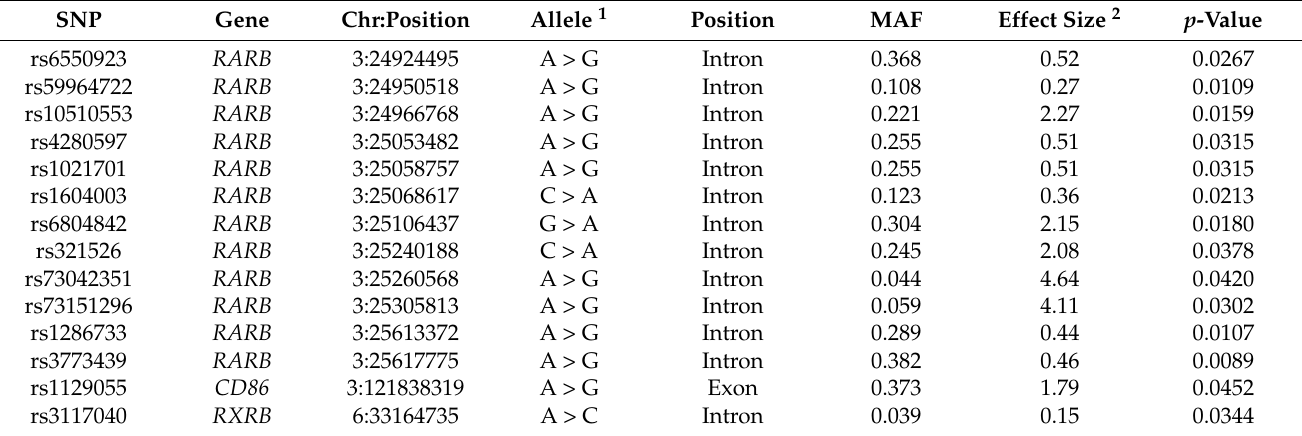
Table 1. SNPs significantly associated with retinol-induced